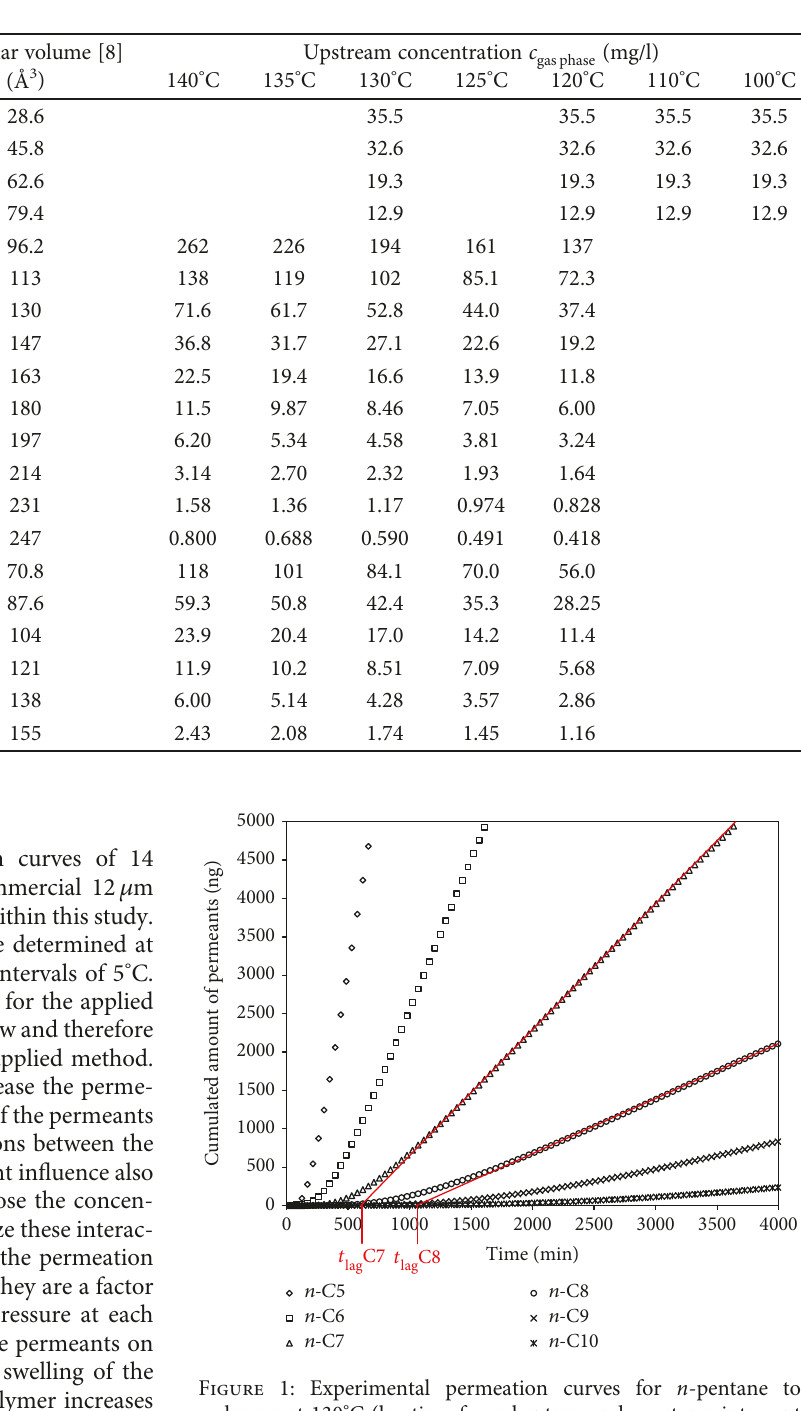
Table 1: Substances used for permeation testing, their molecular weights and volumes, and the upstream concentrations used in permeation testing.